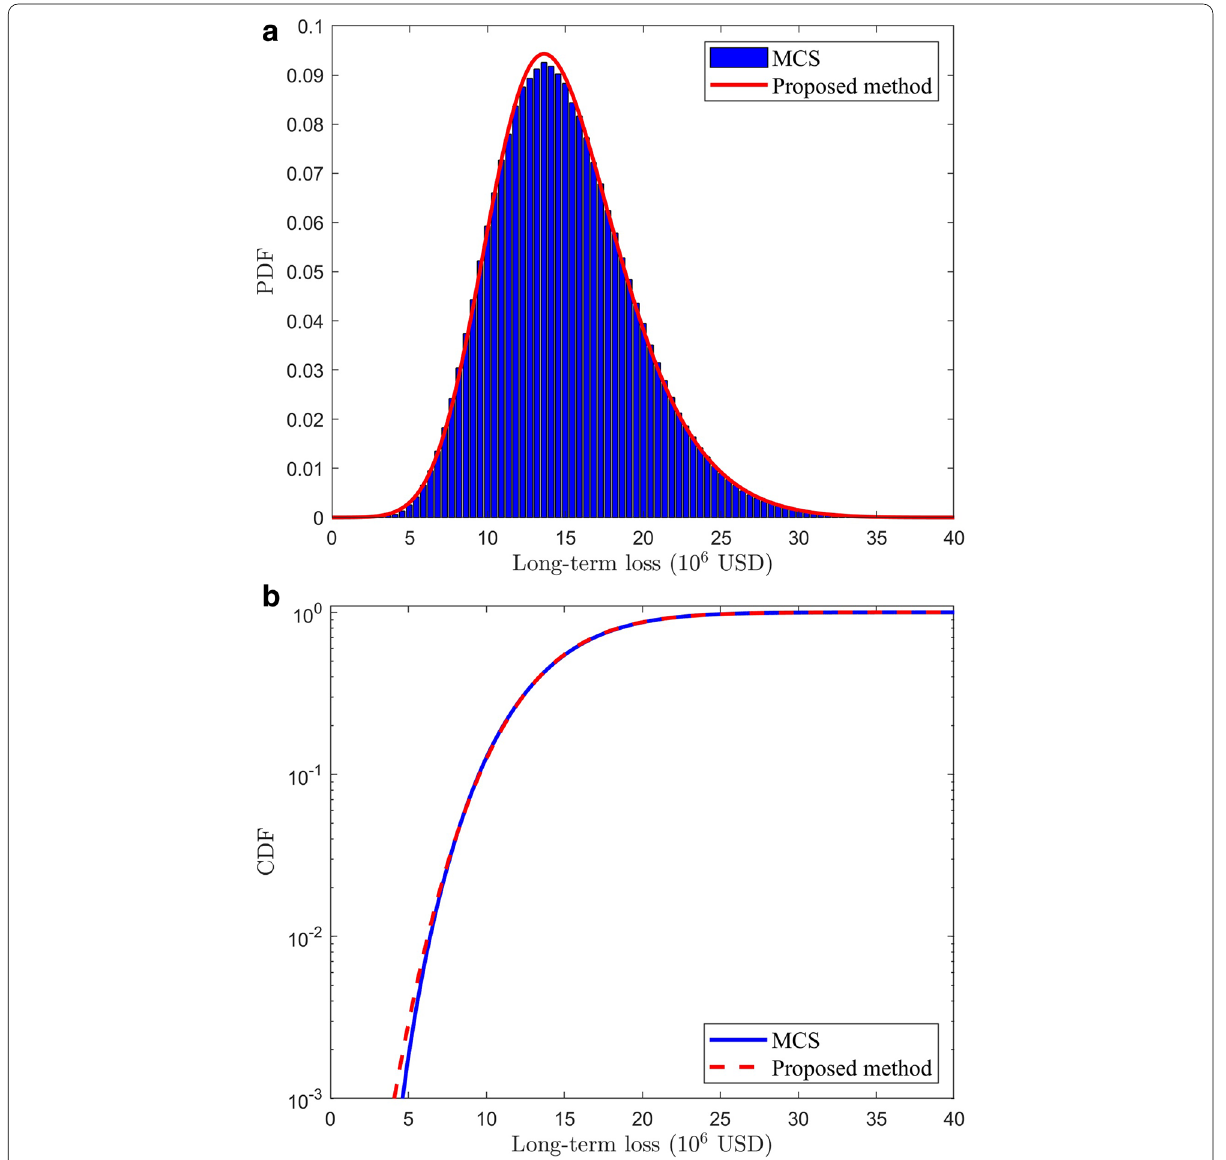
Fig. 4 ( a ) PDF and ( b ) CDF of long-term loss obtained by Monte Carlo simulation and proposed method (150 years, r